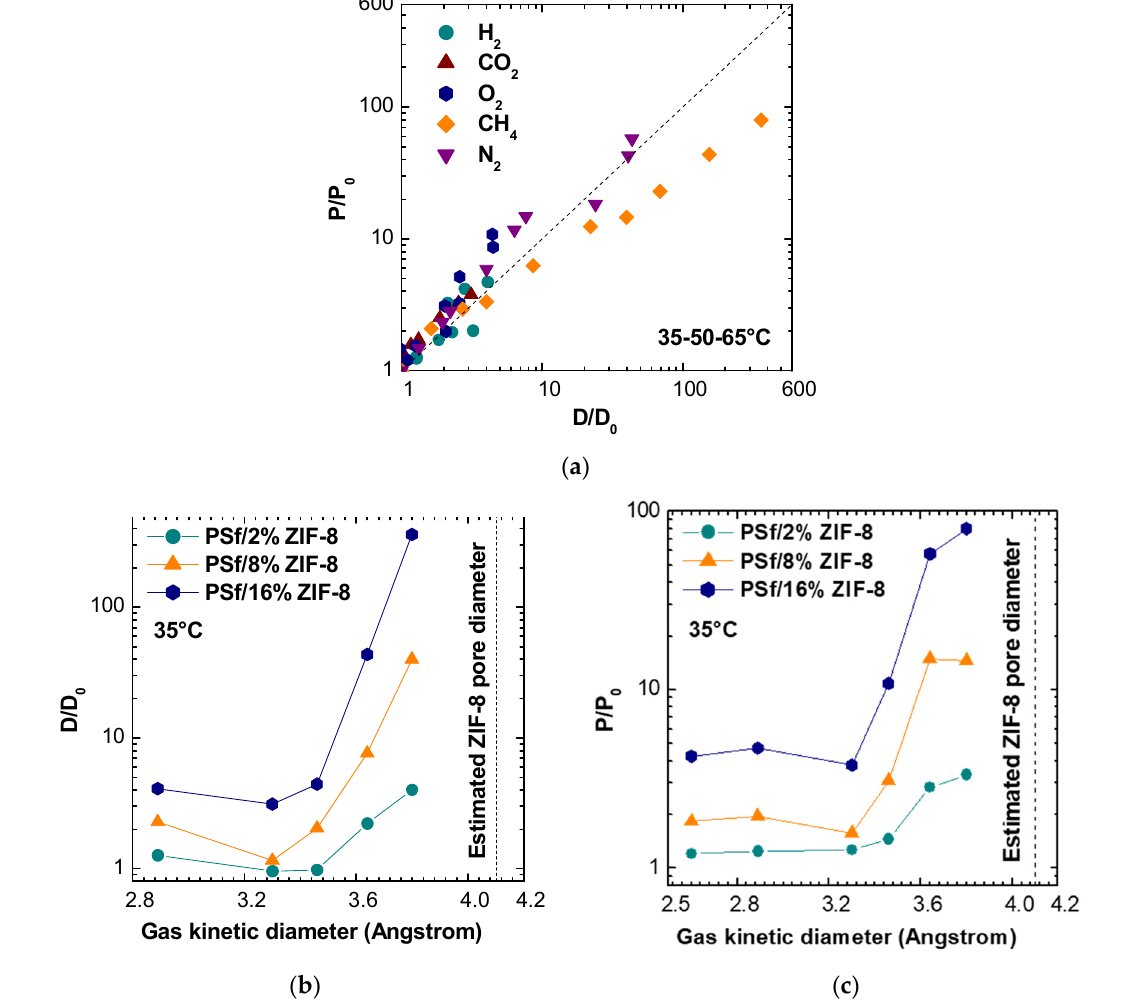
Figure 13. ( a ) Comparison between the permeability and diffusivity enhancement for various gases at different temperatures, observed after addition of variable amounts of ZIF-8 in PSf. ( b ) Diffusivity enhancement versus gas kinetic diameter, for different PSf/ZIF-8 MMMS, at 35 °C. ( c ) Permeability enhancement versus gas kinetic diameter, for different PSf/ZIF-8 MMMS, at 35 °C.